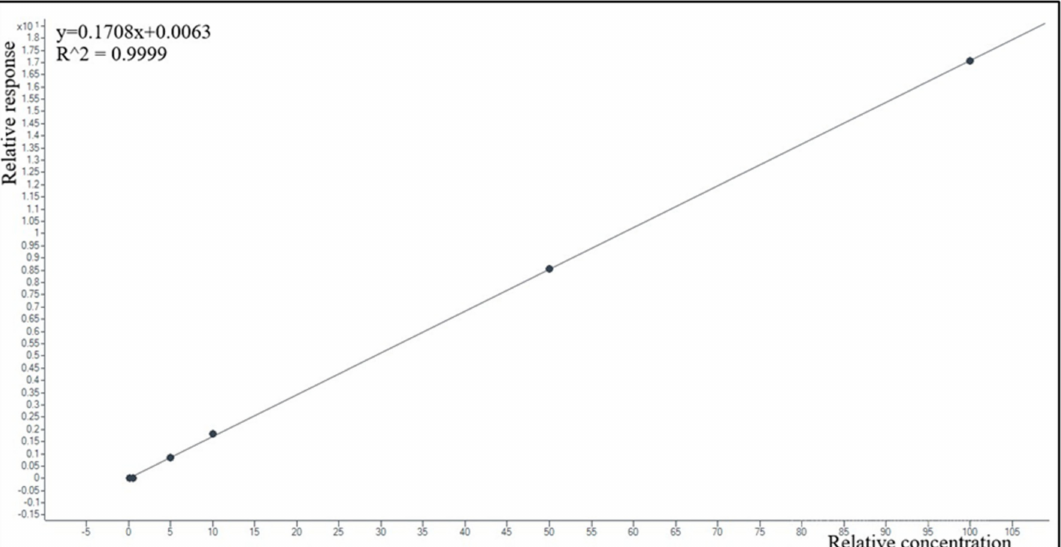
Figure 4. Example of calibrations obtained by plotting the VBR/AVI-C13 area ratio (response) over- concentration, in the 0.1–100.0 mg/L range, by software fitting of 6 experimental calibration points with the linear equation and correlation coefficient reported in the upper left corner of the